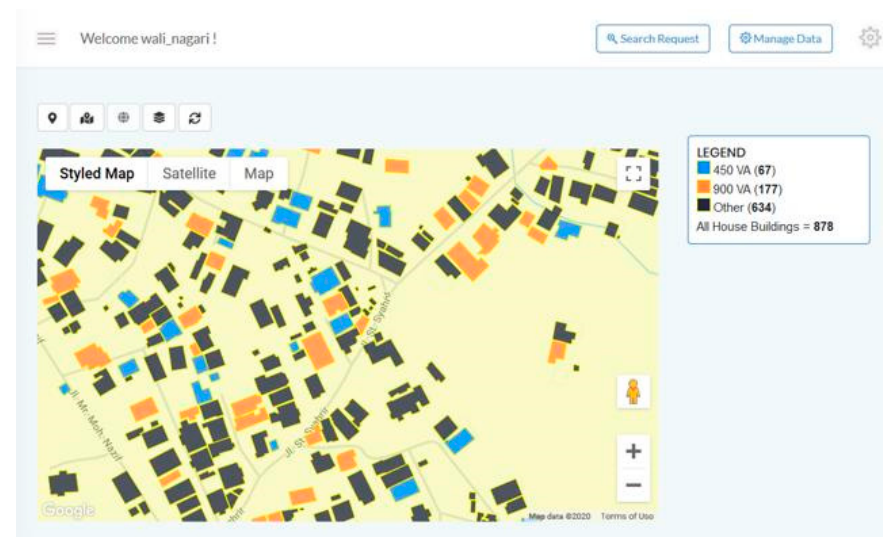
Figure 17. Map of the distribution of people’s homes based on the use of electricity.